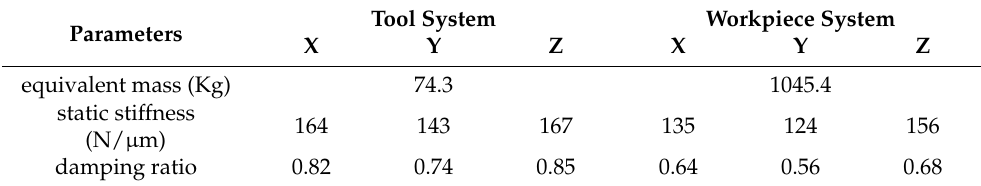
Table 6. Mass, damping, and stiffness of tool and